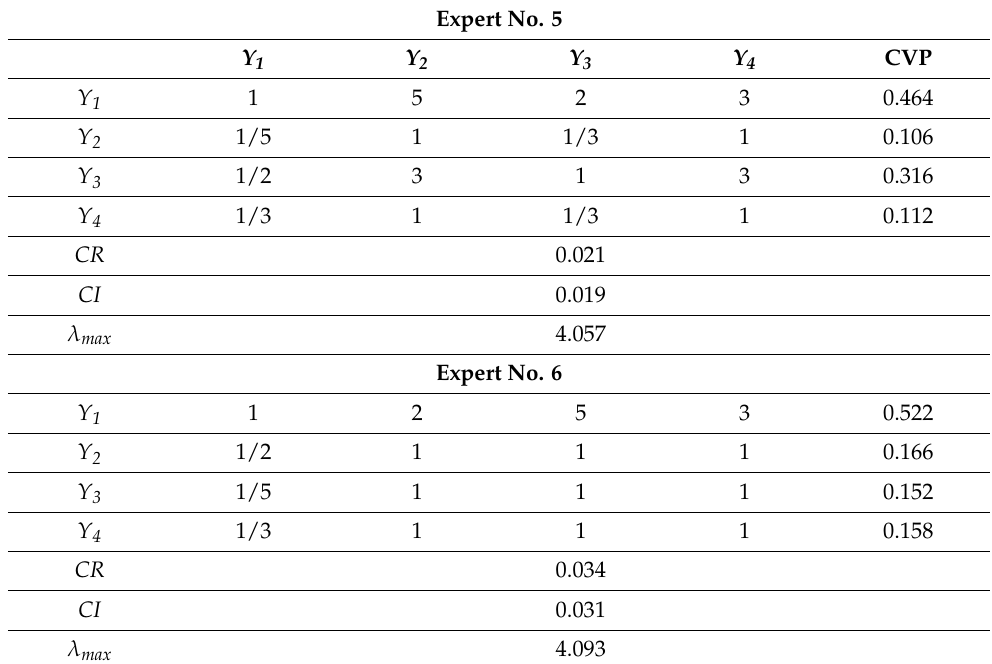
Table 8. Pairwise comparisons of symptoms under continuous interruption of a through short circuit